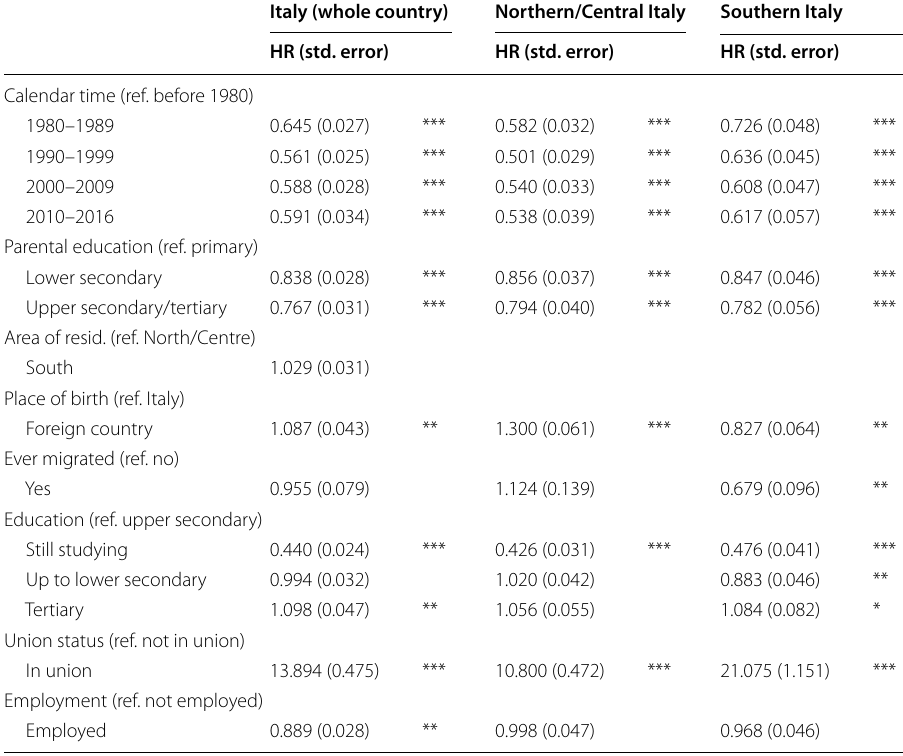
Table 8 Employment status and transition to motherhood with control for time-varying union status. Cox models, HRs are reported with standard errors in brackets